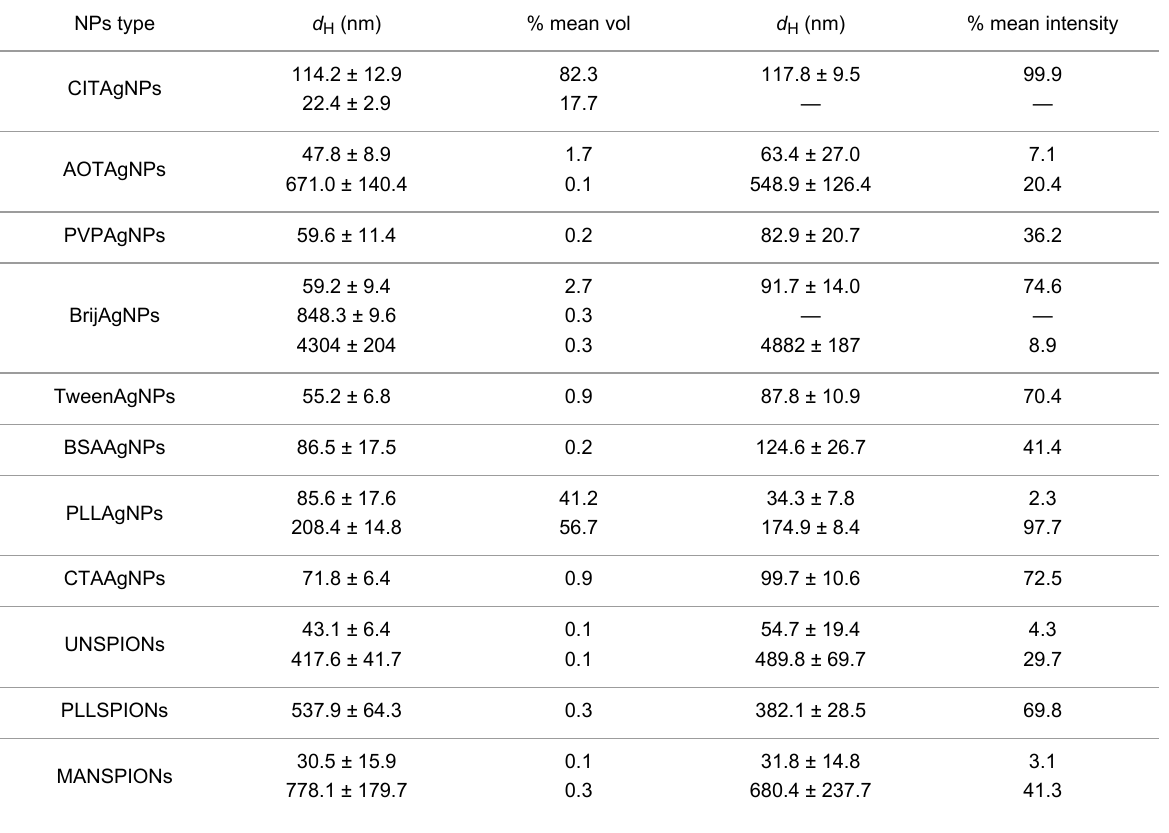
Table 3: Hydrodynamic diameter ( d H ) obtained from size distributions by volume and intensity of differently coated silver (AgNPs) and superpara- magnetic iron oxide nanoparticles (SPIONs) in biological medium supplemented with 0.1% bovine serum albumin (BMP) after 1 h at 25 °C. Coating agents: trisodium citrate (CIT), sodium bis(2-ethylhexyl) sulfosuccinate (AOT), poly(vinylpyrrolidone) (PVP), Brij 35 (Brij), Tween 20 (Tween), bovine serum albumin (BSA), poly(L-lysine) (PLL), cetyltrimethylammonium bromide (CTA) and D-mannose